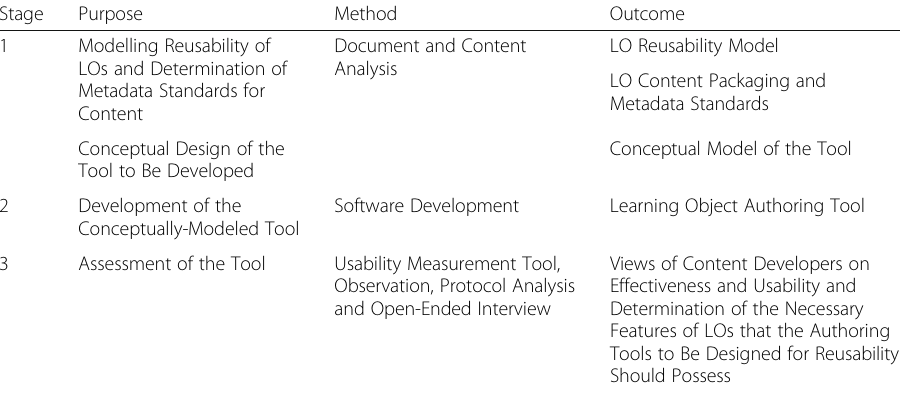
Table 1 Purpose of the study and methods implemented